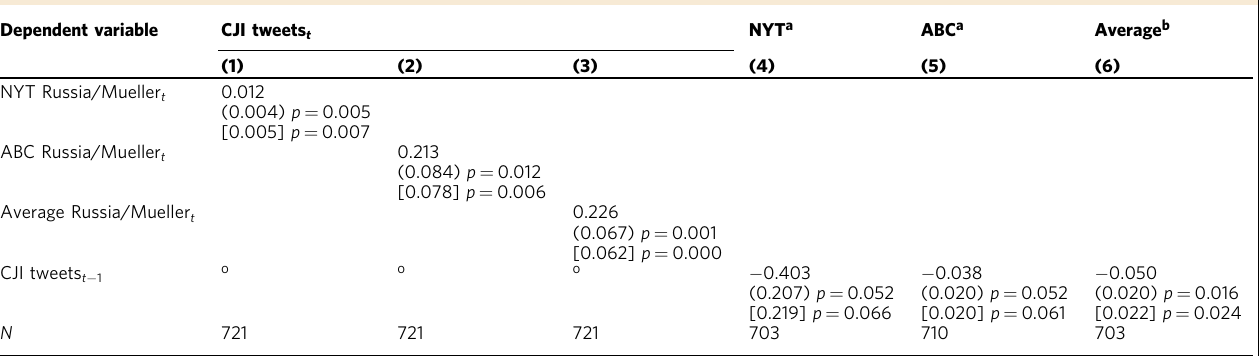
Table 1 Predicting diversionary tweets (CJI) from threatening media coverage (Russia-Mueller; columns 1 – 3) and predicting suppression from diversionary tweets (columns 4 –